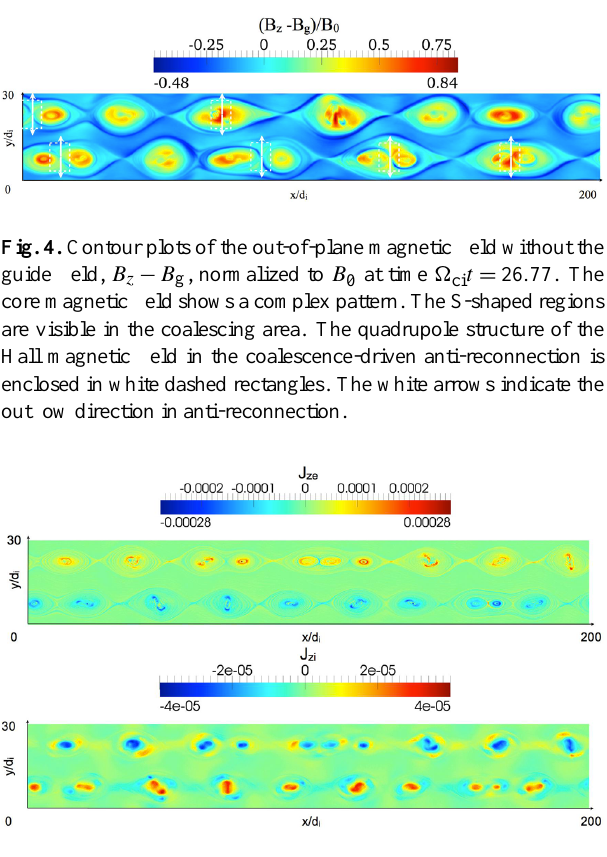
Fig. 5. Contour plot of the out-of plane electron and ion currents, J z e and J z i , normalized to en 0 c , at time (cid:127) ci t = 18 . 62. The total current is supported only by the electrons while the the ions generate a current in the opposite